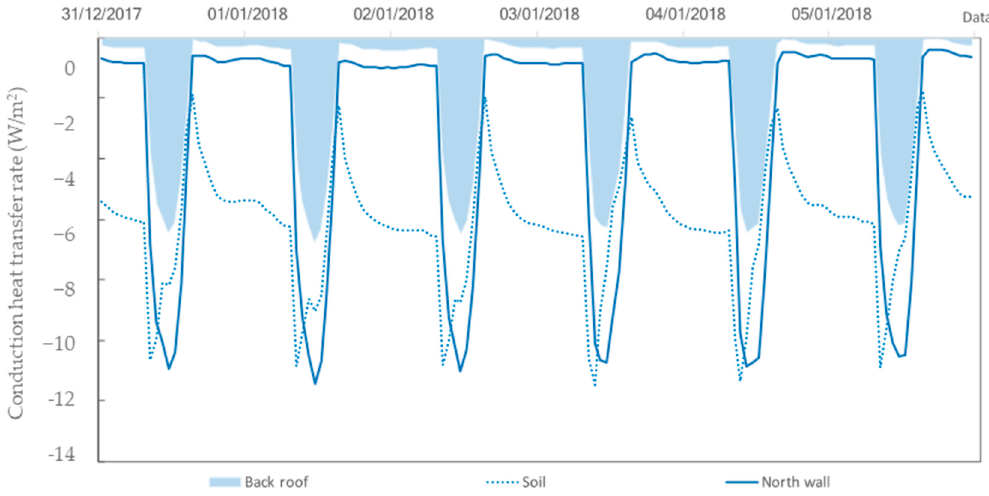
Figure 24. Convection heat transfer on the inside surfaces of the CSG on clear days.